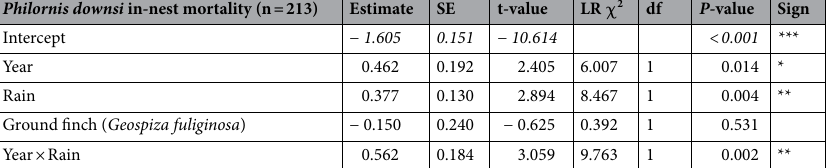
Philornis downsi in-nest mortality (n = 213) Estimate SE t-value LR χ 2